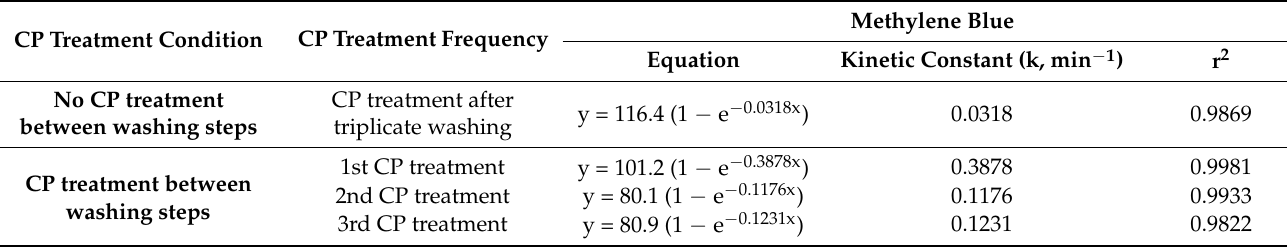
Table 2. Kinetic equations of methylene blue removal efficiencies.